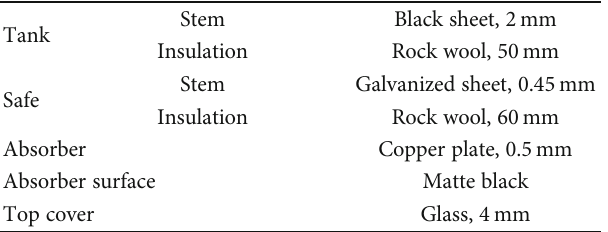
Figure 3: Parts of the heat pipe solar collector. Table 4: Technical characteristics of the